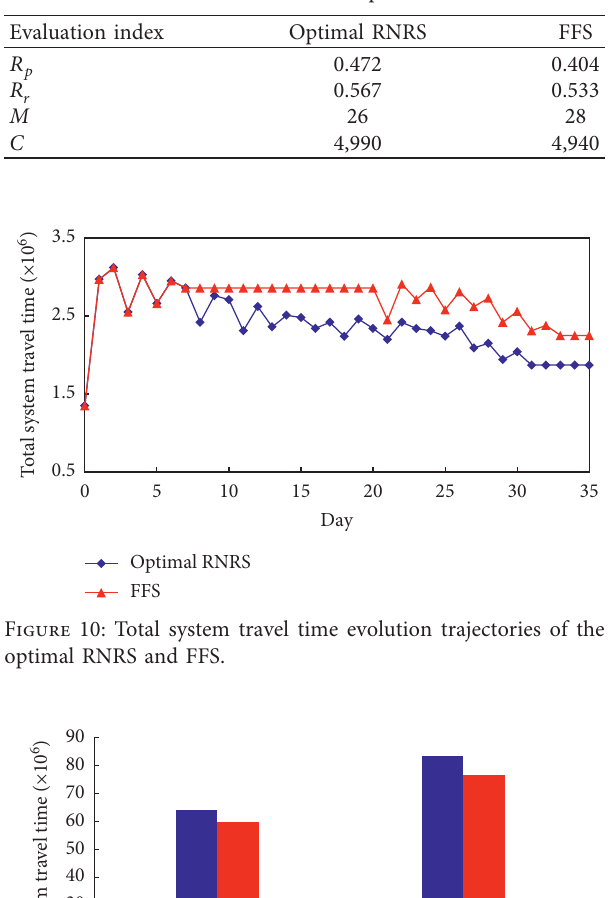
Table 4: Restoration results of the optimal RNRS and FFS.